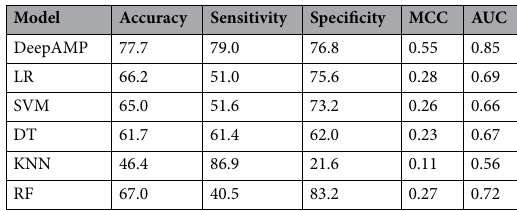
Table 2. Different models result on AMPylation dataset (10 fold CV).